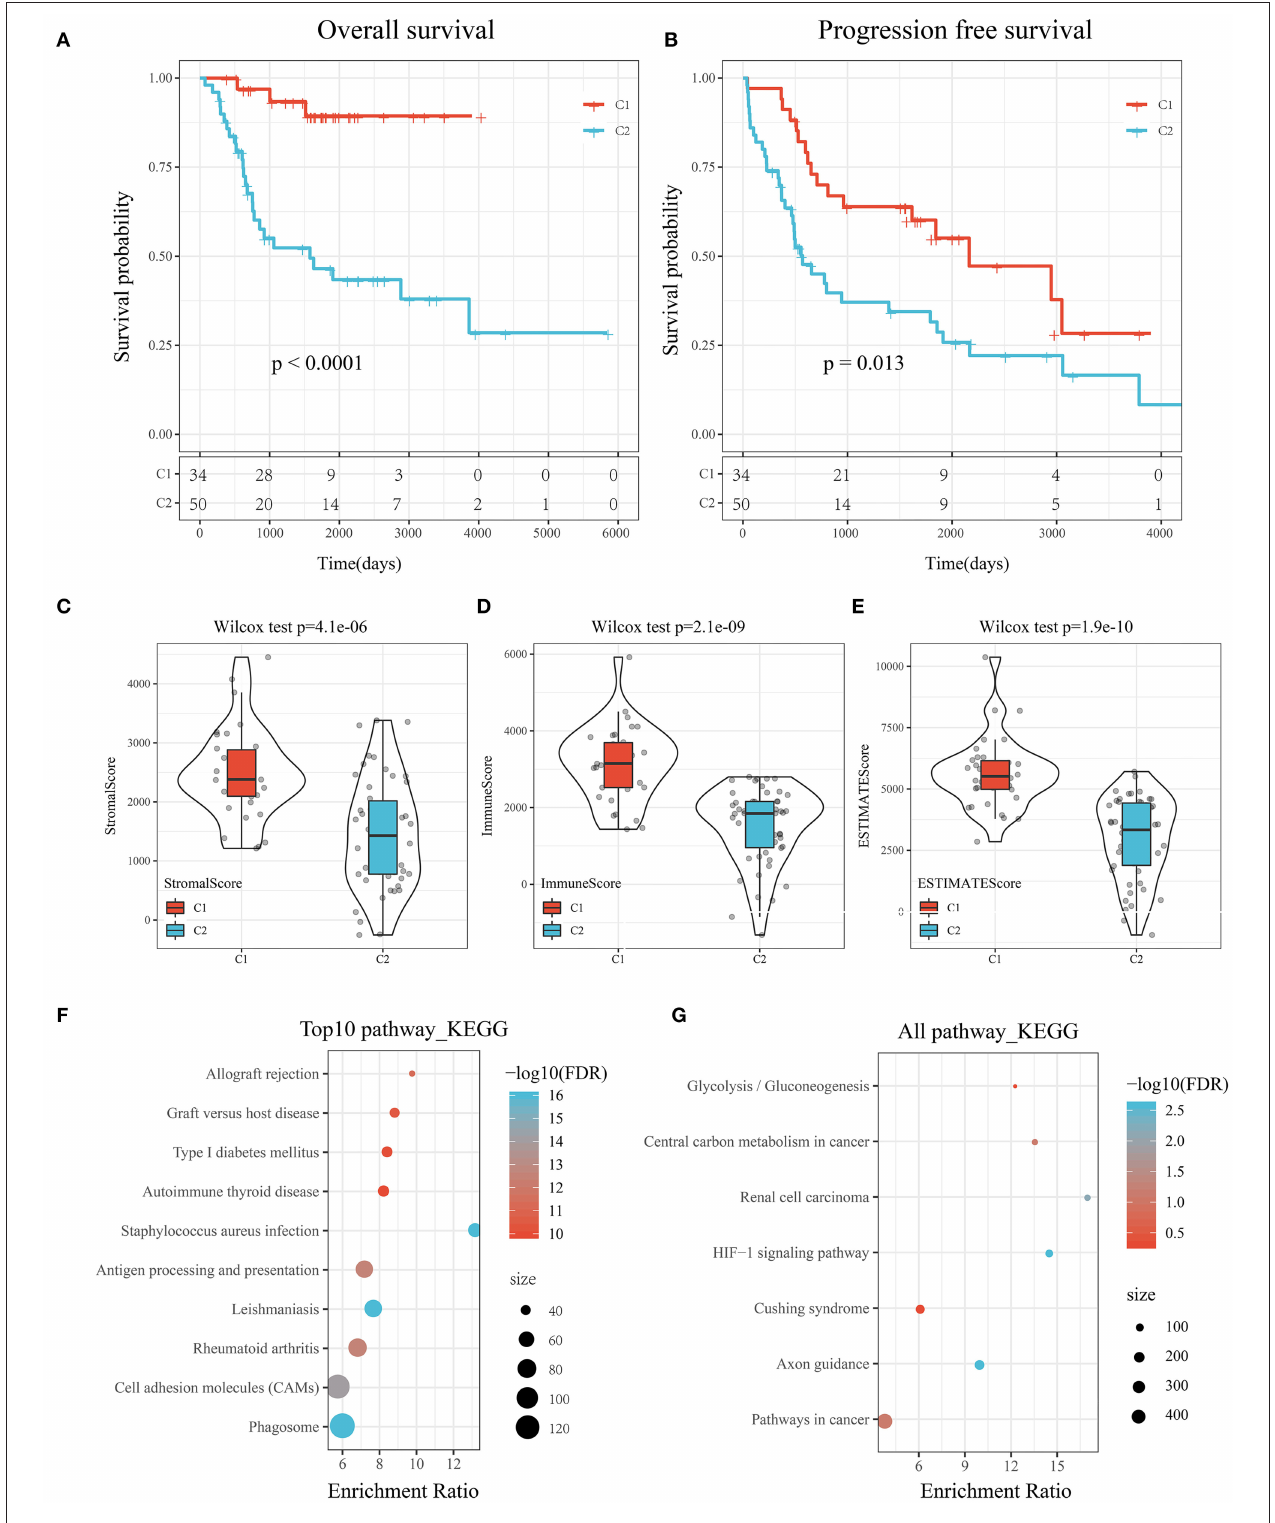
FIGURE 3 | (A) KM curve of the overall survival of the subtypes of the TARGET tumor samples. (B) KM curve of the progression-free survival of the subtypes of the TARGET tumor samples. (C) Comparison of stromal scores between C1 and C2. (D) Comparison of immune scores between C1 and C2. (E) Comparison of ESTIMATE scores between C1 and C2. (F) KEGG pathway analysis of the upregulated DEGs between the molecular subtypes. (G) KEGG pathway analysis of the downregulated DEGs between the molecular subtypes.